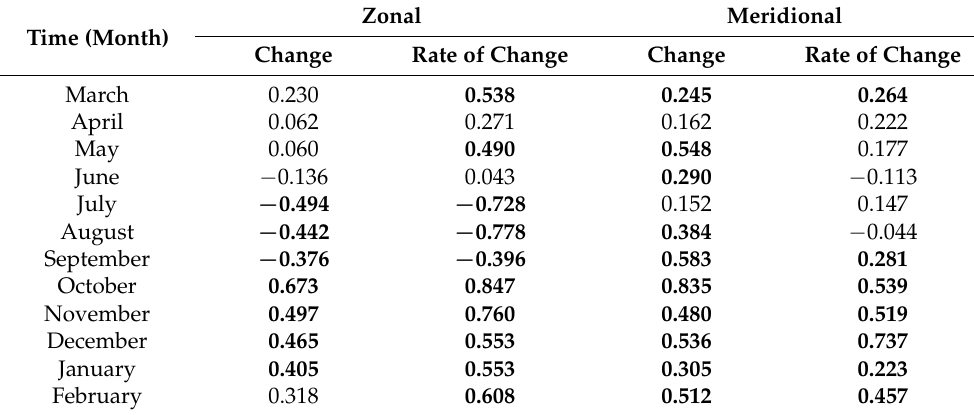
Table 2. The Pearson correlation coefficient between the GW Ep and the elevation from August 2006 to September 2020. The correlation coefficients that pass the 95% significance test are in